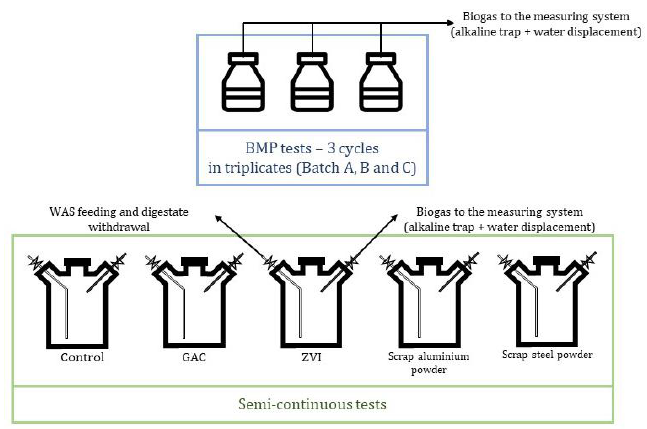
Figure 1. Experimental design scheme.